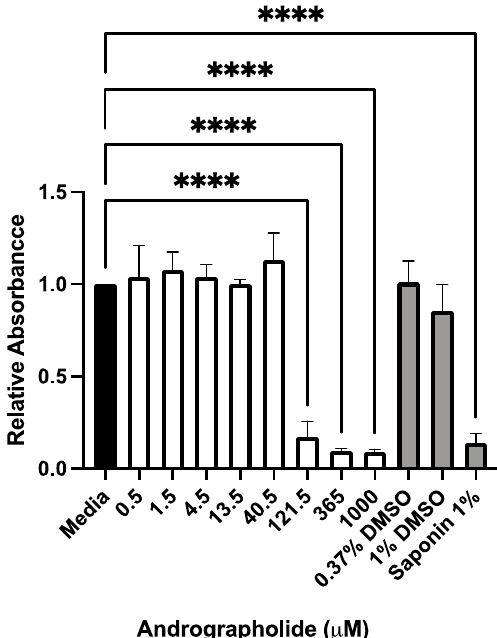
Figure 1. Andrographolide demonstrated a dose-dependent cytotoxicity in rabbit corneal fibroblasts (RCFs) in vitro . Treatment with andrographolide resulted in significant cytotoxicity in RCFs at concentrations of 121.5 μ M and greater. Relative absorbance was normalized to media alone, DMSO treatments served as vehicle controls, saponin 1% served as a positive control for cytotoxicity. Bars indicate mean relative absorbance and error bars indicate standard deviation ( n = 3 independent experiments). One-way ANOVA with a Dunnett’s multiple comparisons test performed with **** equivalent to p < 0.0001).